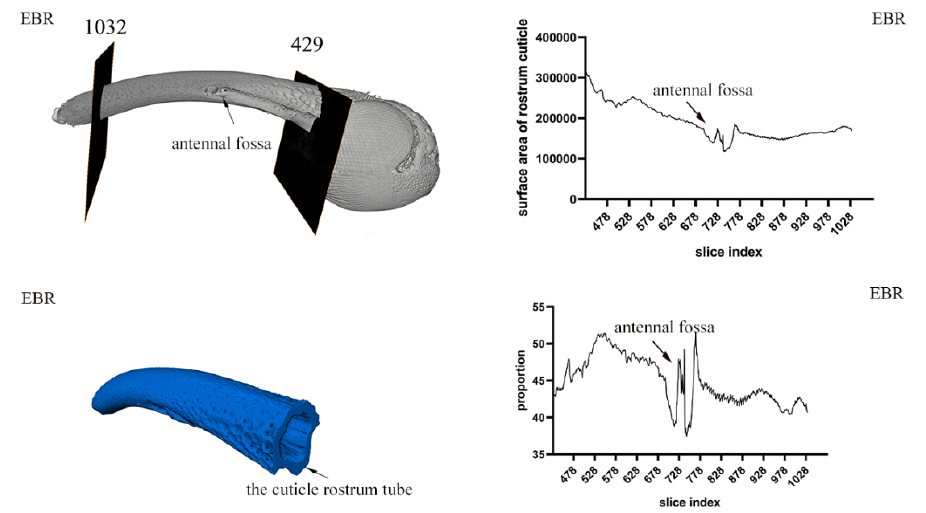
Figure 6. The rostral cuticle thickness of Eucryptorrhynchus brandti (EBR) females. The left is the